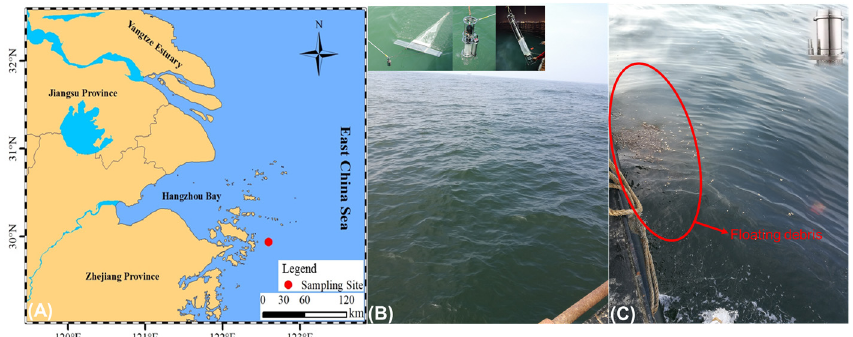
Figure 1. Sampling site in the East China Sea ( A , 122°35 ′ 46 ″ E, 29°56 ′ 16 ″ N) and the sea surface conditions when the sampling was conducted. ( B ) Clear sea surface when Manta trawl, shallow-water plankton pump (SPP), and deep-water plankton pump (DPP) were deployed; ( C ) A mass of debris floated over when the submersible pump was deployed using 50 µm and 300 µm mesh. Photos of the sampling devices here were taken in other sampling campaigns and used here just for illustration.